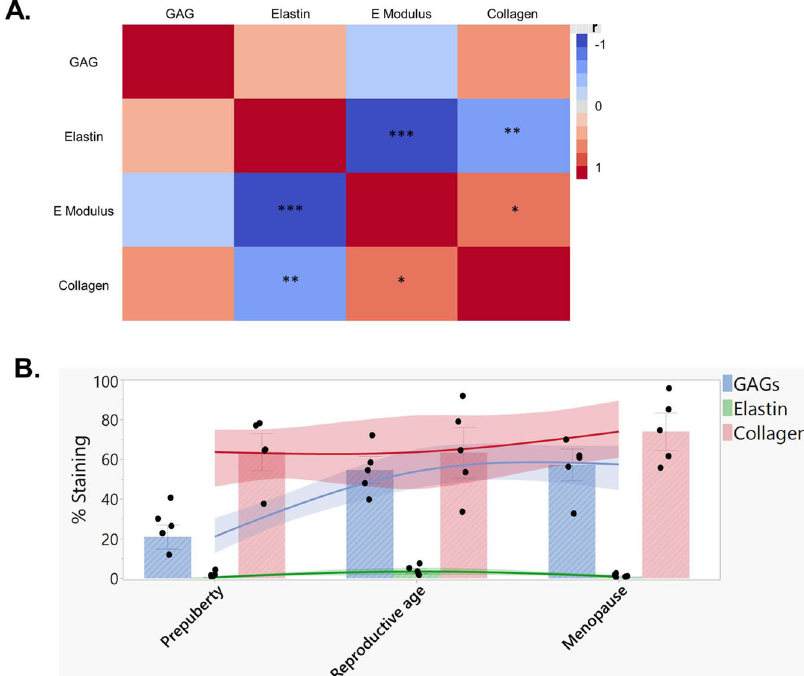
Fig. 7 Linking biochemical to biophysical properties. A Correlation matrix of elastic matrisome components and apparent elastic modulus measured in study subjects. Histological staining was used to characterize glycosaminoglycans (GAGs), collagen abundance, and immuno fl uorescent staining of elastin 17 . Computer-assisted quanti fi cation of staining was based on the following equation: % stained area = (stained area/region of interest (ROI) area) × 100 expressed as a percentage. A correlation matrix was constructed using JMP Pro 14.3.0 (SAS, France, Grégy-sur-Yerres). Spearman ’ s correlation was used to measure the strength and direction of association ( r ) between each pair of variables. P collagen – elastin = 0.0058; P = 0.0148; P Emodulus – collagen Emodulus – elastin < 0.0001. B Changes in collagen, elastin, and GAG levels with age are summarized in bar charts, presented as mean ± SD, n = 5 biologically independent samples per age group. The data plot fi ts a smoothing spline with a lambda value of 0.05. The curves also include the bootstrap con fi dence region for each fi t generated by JMP Pro 14.3.0. * p < 0.05; ** p < 0.01; *** p <